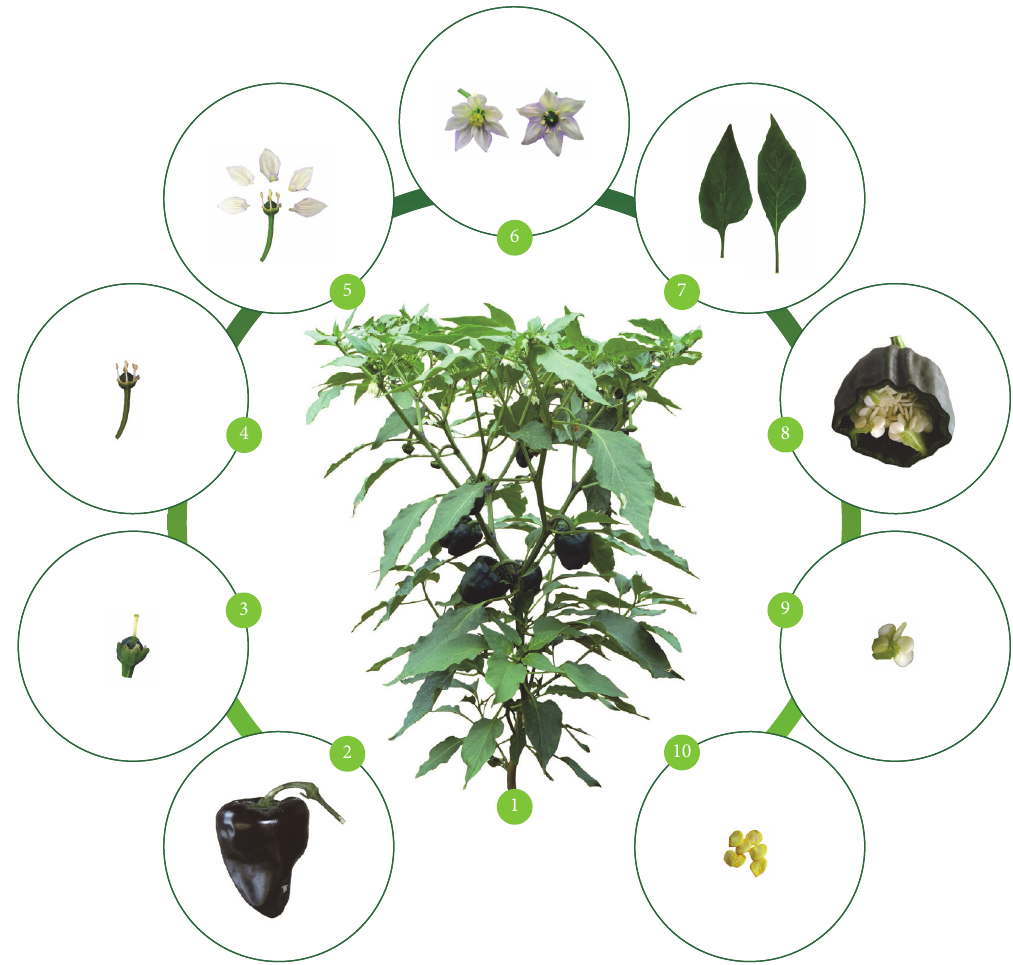
Figure 3: Morphology of a mature chilhuacle chili plant and anatomy of fruits. (1) A chilhuacle plant during fruit development. (2) A mature fruit.(3)Astigma.(4)Stamens.(5)Petals.(6)Flowers.(7)Leaves.(8)Crosssectionofimmaturefruitshowingseptumandseeds.(9)Immature seeds of the fruit. (10) Mature seeds are yellow.